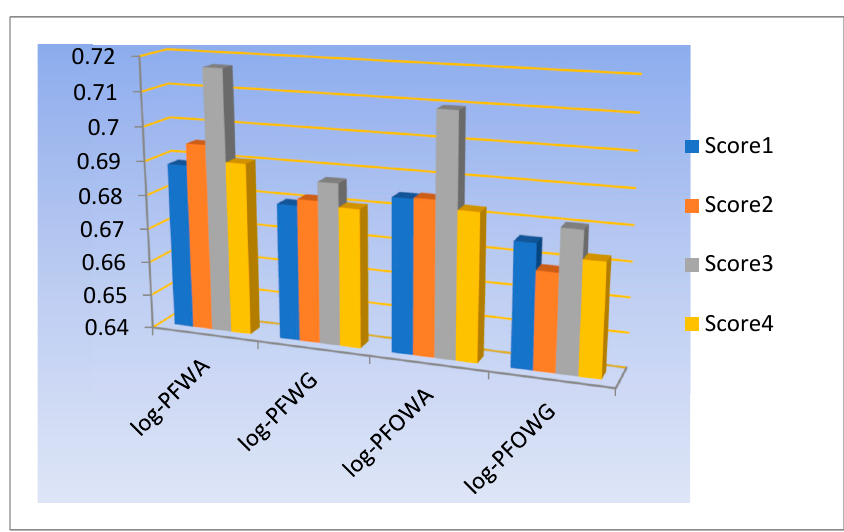
Figure 2. Score comparison of alternatives.